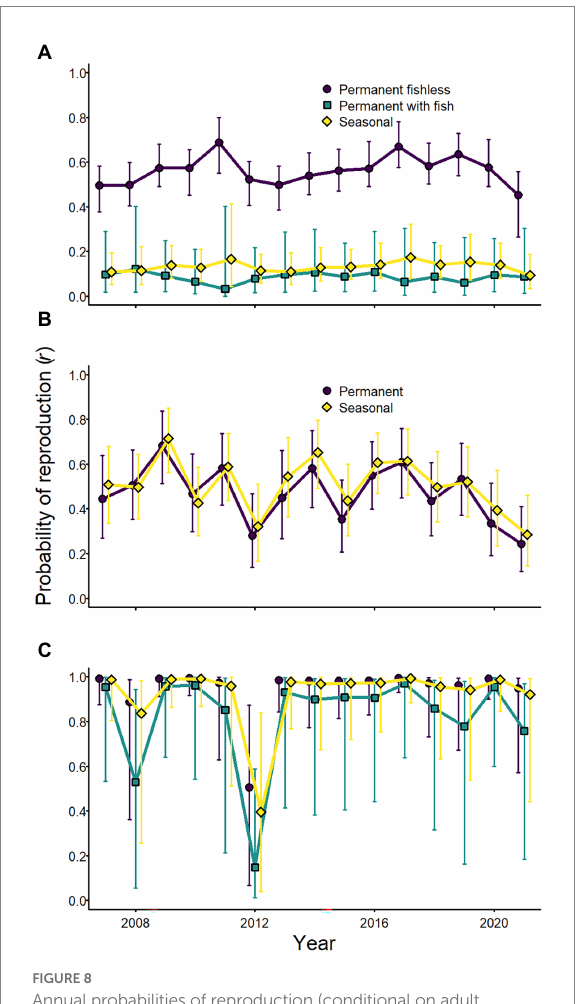
FIGURE 6 Probability of extirpation for Sierra Nevada yellow-legged frogs [ Rana sierrae ; (A) ], Yosemite toads [ Anaxyrus canorus ; (B) ], and sierran treefrogs [ Pseudacris sierra ; (C) ] in relation to the minimum Palmer Drought Severity Index (PDSI) in September and site type (indigo shading and solid line = permanent [and fishless for panels (A,C) ]; aqua shading and dashed line = permanent with fish; gold shading and dotted line = seasonal) in Yosemite National Park, California, United States, 2007–2021. Lines represent posterior modes and shading intensity represents the posterior probability distribution.